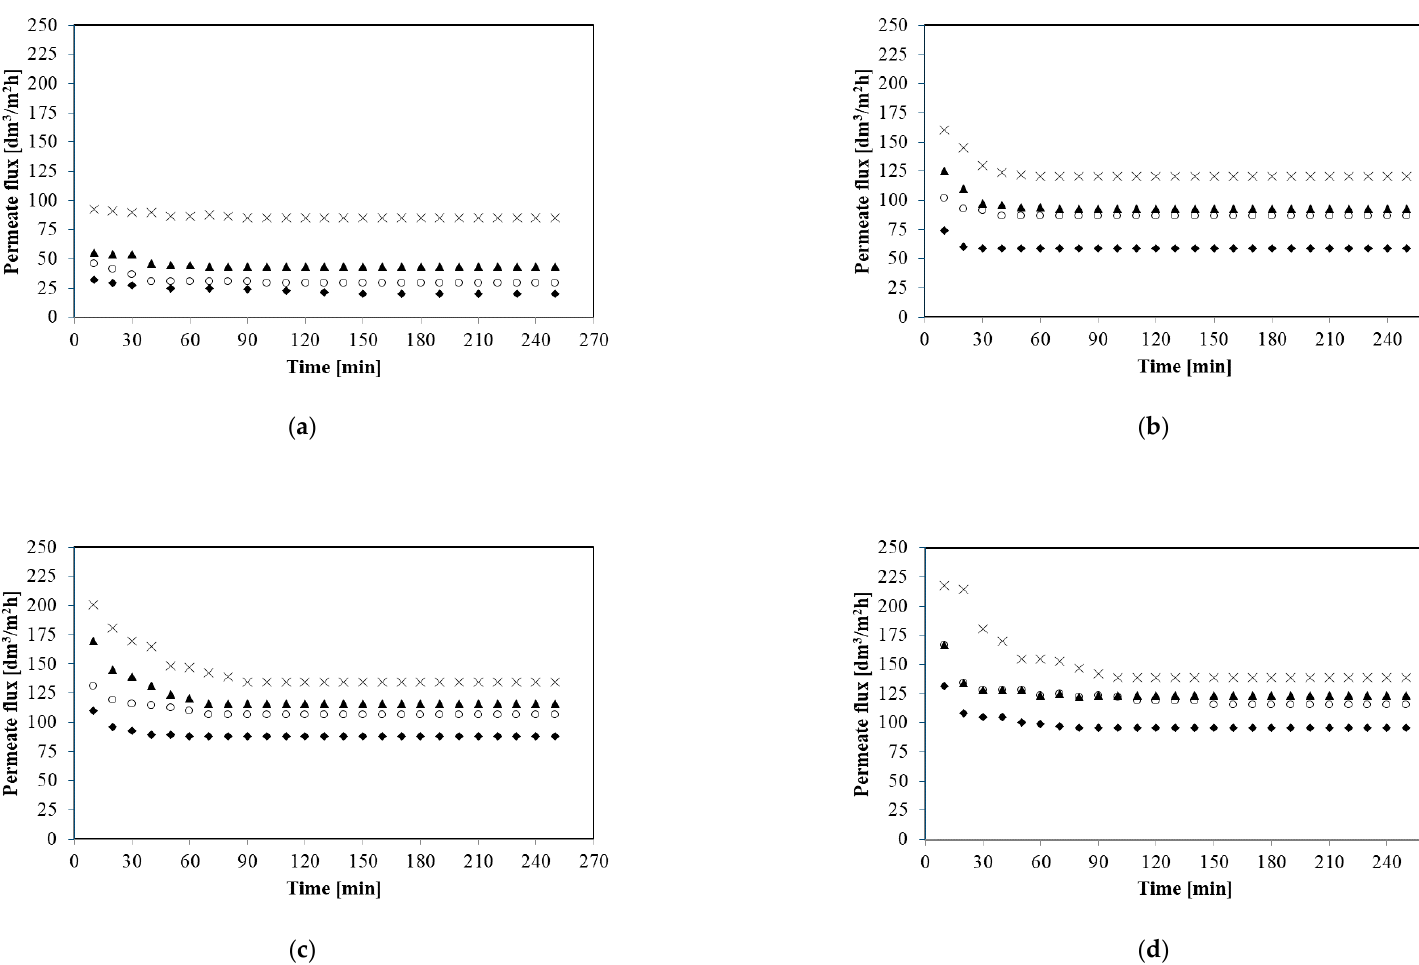
Figure 4. E ff ect of feed flow rate on the permeate flux. ( a ) 0.02 MPa; ( b ) 0.06 MPa; ( c ) 0.10 MPa; and ( d ) 0.12 MPa. Q [dm 3 / h]: (cid:95) 1000.